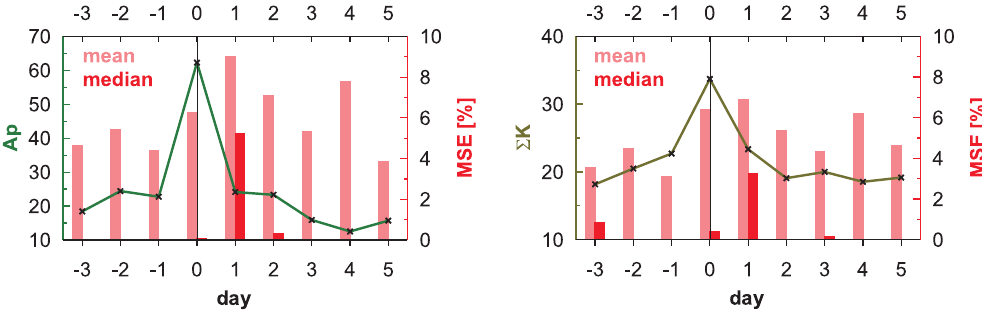
Fig. 1. Left part: Superimposed epoch analysis of the MSE occurrence rates (red bars) and the corresponding A p indices (green curve) using for key day 0: A p max ≥ 35 basing on 22 intervals during 1998–2006. Right part: As left panel but using here the local geomagnetic indices 6K at Niemegk with 6K max ≥ 30 for 23 intervals.